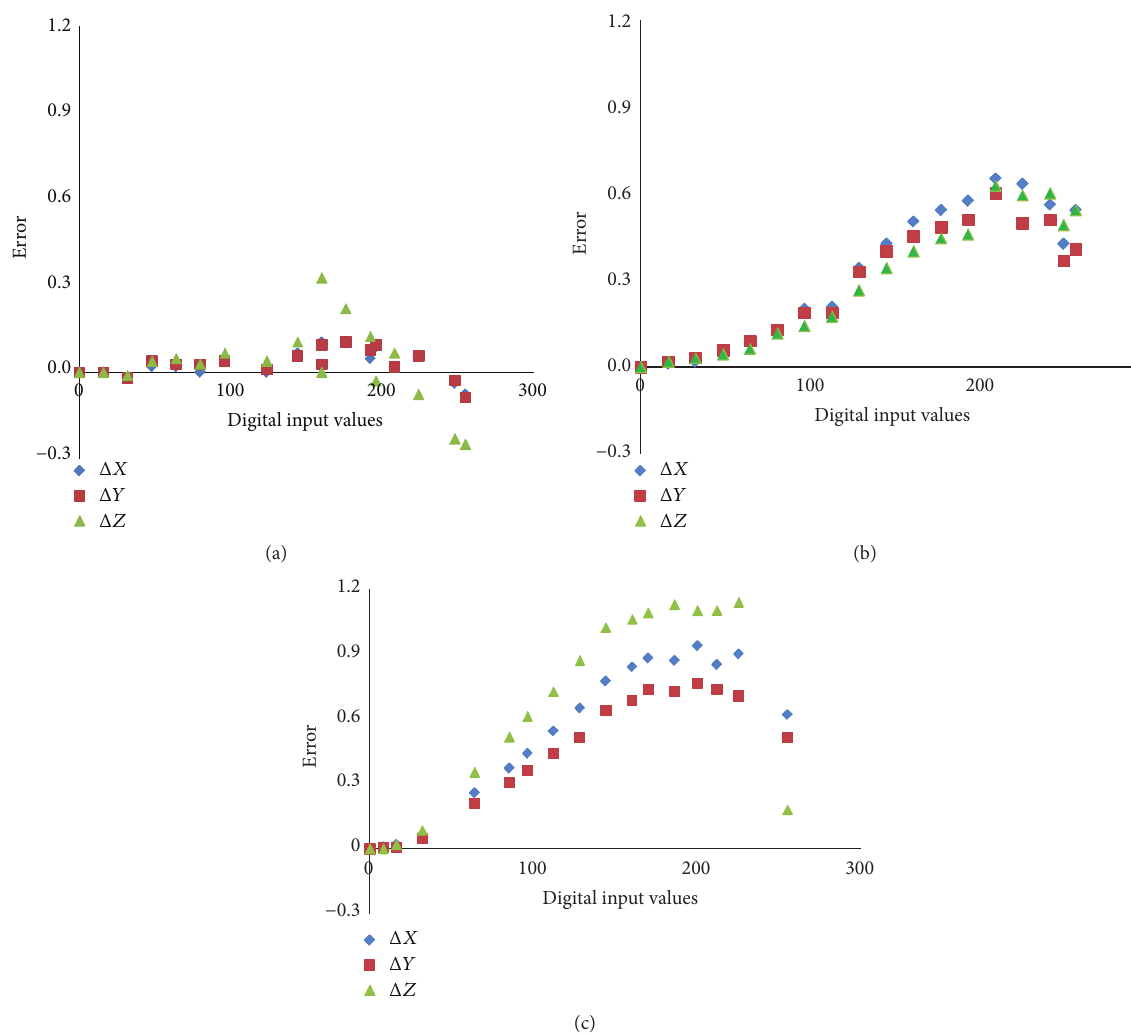
Figure 4: Channel dependence errors of different devices: (a) EIZO; (b) NEC; (c)